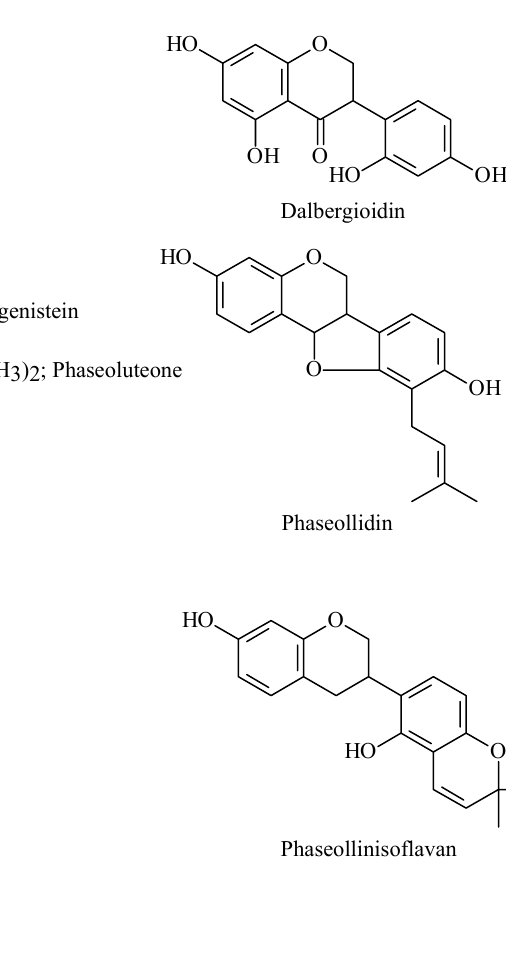
Figure 1. Phytoalexins isolated from Colombian bean